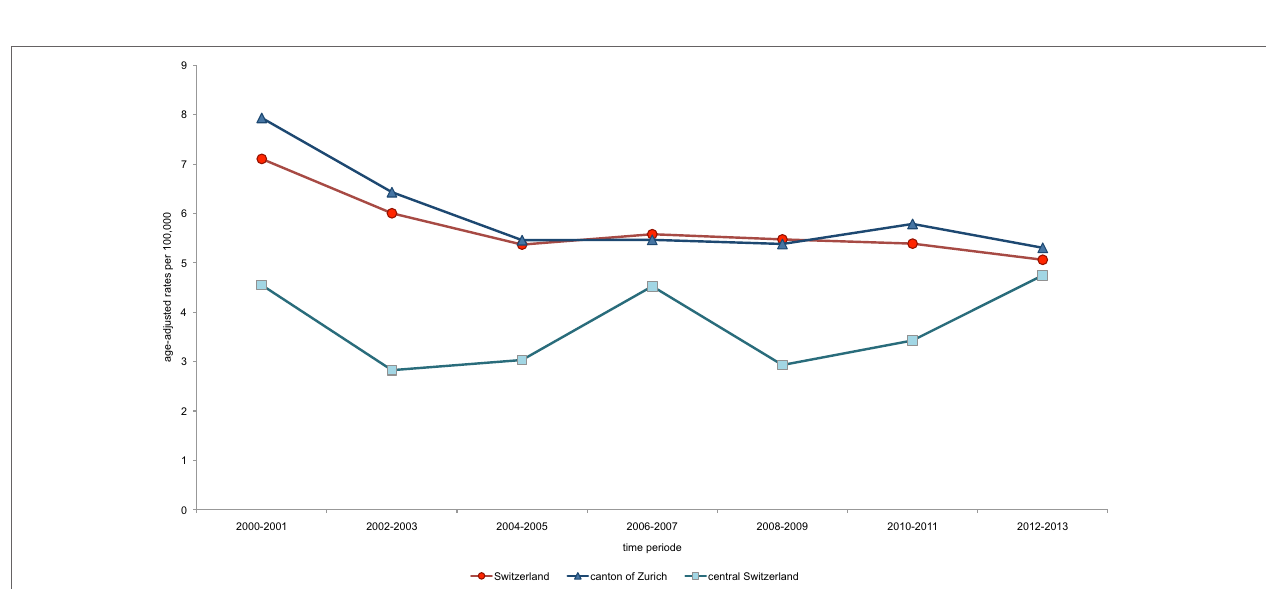
FigUre 4 | Trends in number of histological subtypes of cervical cancer (CC) by FIGO stage at time of diagnosis, Central Switzerland 2000–2014. There is a trend of increasing numbers of findings with FIGO IA ( p -value 0.077) and a significant increase of findings FIGO > II ( p -value < 0.001). If CC was diagnosed in FIGO IA, adenocarcinoma (AC) was found in 9.8% and squamous cell carcinoma (SCC) in 90.0%, compared to FIGO IB with 29% of AC and 71% of SCC.